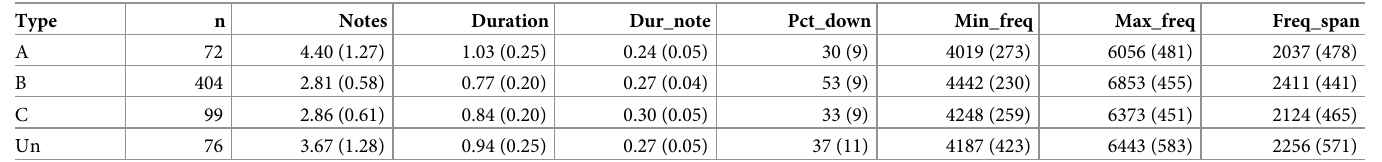
Table 1. Summary statistics for measures of Louisiana Waterthrush song types.